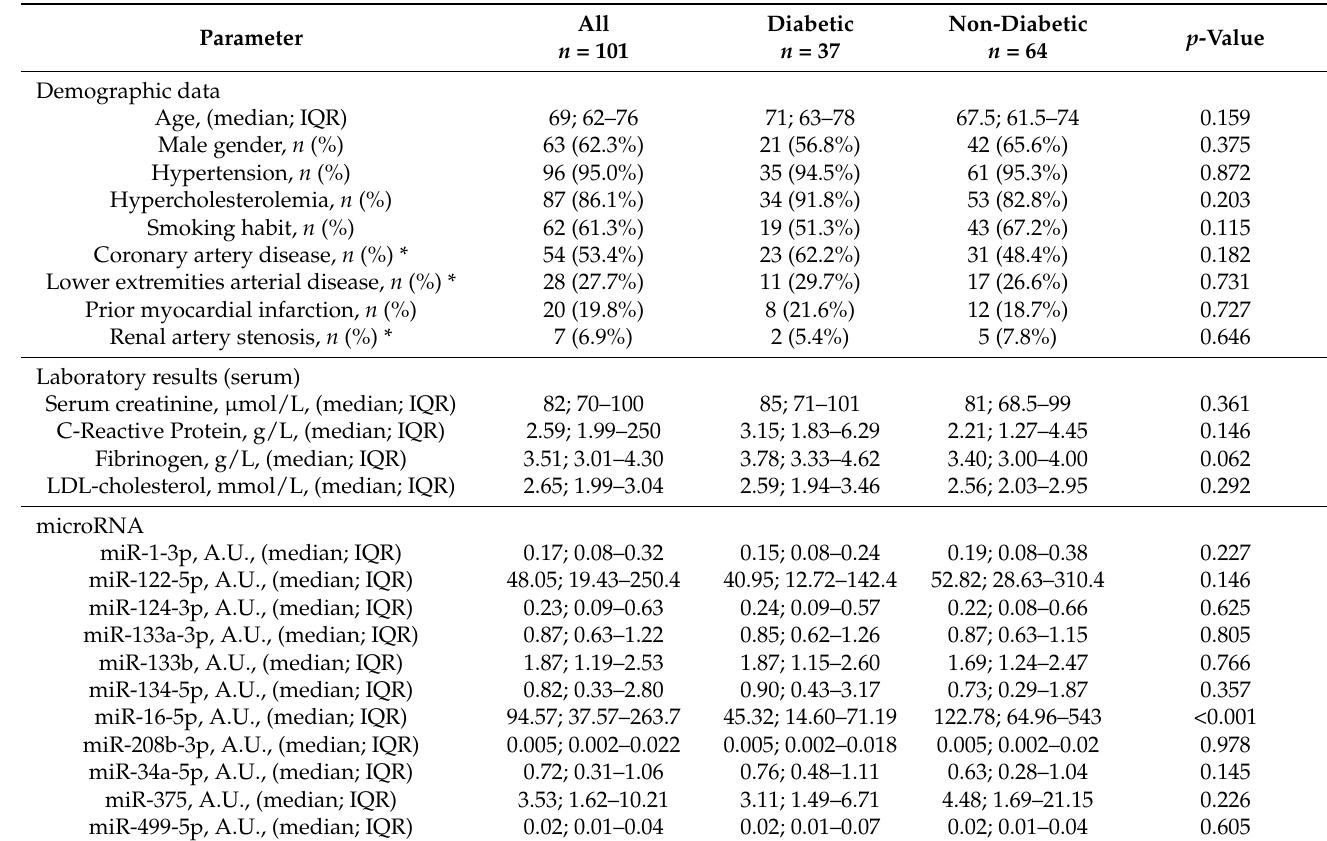
Table 1. Baseline patients’ characteristics. Comparison of patients with symptomatic internal carotid artery stenosis with diabetes and without diabetes.